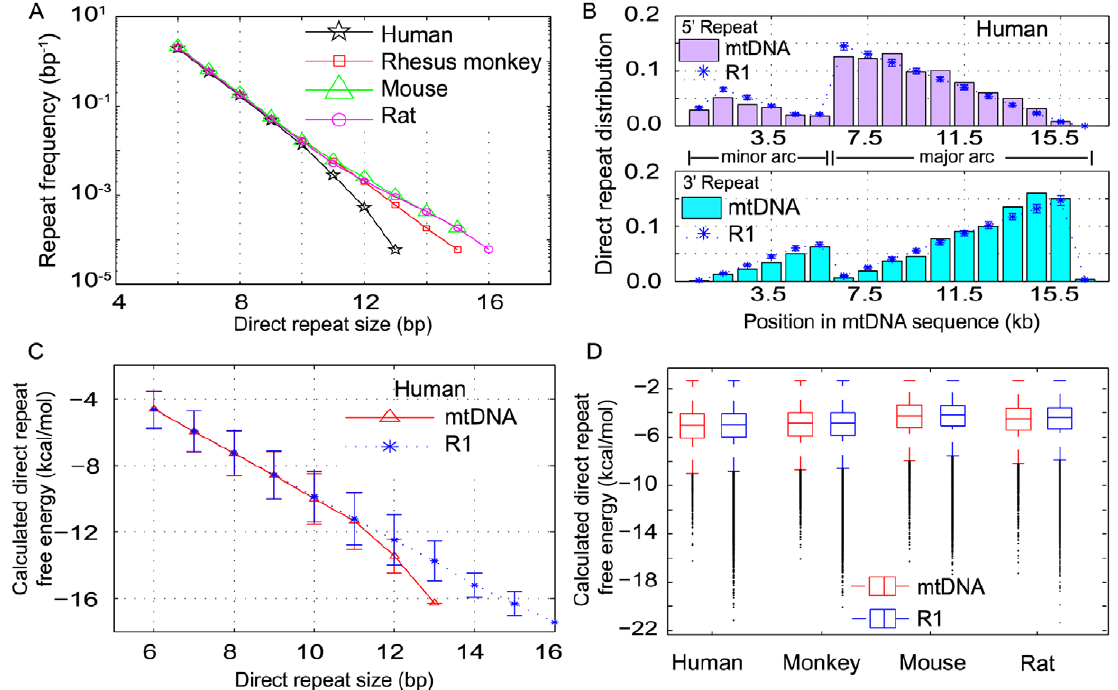
Figure 1. Analysis of direct repeat (DR) motifs in mitochondrial genomes. Abundance, distribution and free energy of DRs in mtDNA and random DNA sequences ( n =100) with the same base composition (R1) as corresponding mtDNA. (A) Frequency of DR pairs ( $ 6 bp) in the mtDNA of human, rhesus monkey, mouse and rat. The DR frequency is normalized with respect to the mtDNA length in each species. (B) The distribution of left and right DR sequences in the minor and major arcs of human mtDNA and the mean distribution of DRs in R1 random sequences. (C) DR sizes and DR free energies in human mtDNA and the corresponding R1 random sequences. The lower the free energy of a DR, i.e. the more negative, the more stable is the DNA duplex formed. (D) Distribution of free energies of DNA duplex formed by DRs ( $ 6 bp) in native mtDNA and random sequences (R1) of human, rhesus monkey, mouse and rat.